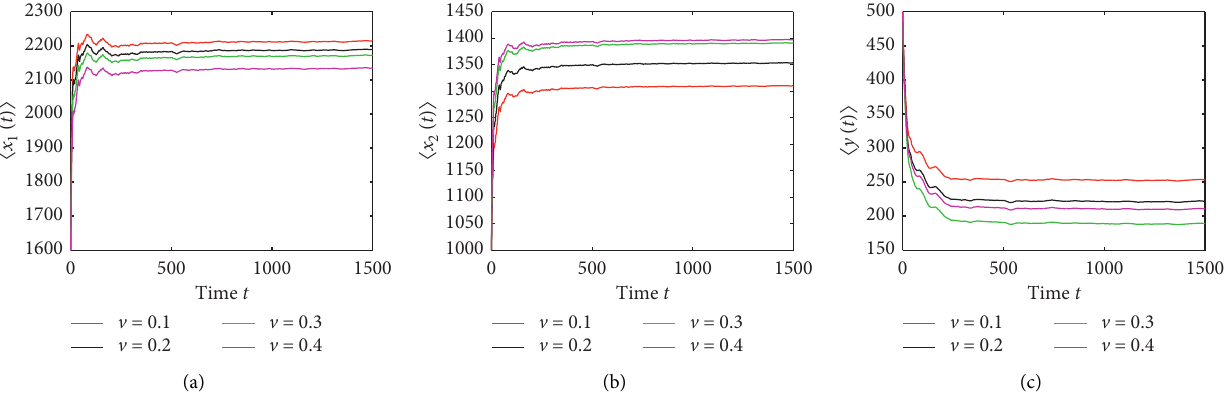
Figure 24: The trajectories of stochastic model (5) with different v (color figure online): (a) prey 〈 x 〈 y ( t )〉